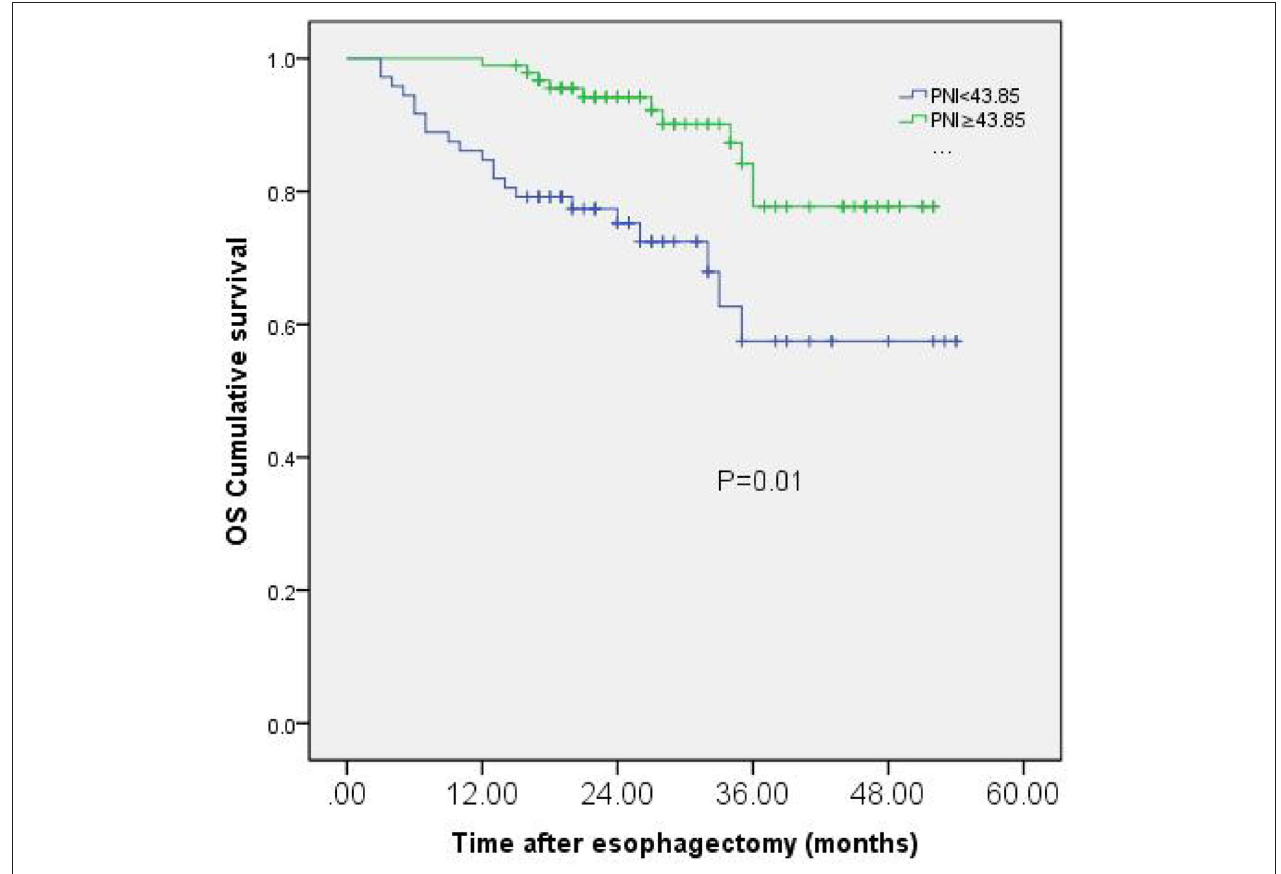
FIGURE 2 | Kaplan-Meier curves of OS based on PNI group in 165 patients with esophageal squamous cell carcinoma (ESCC).